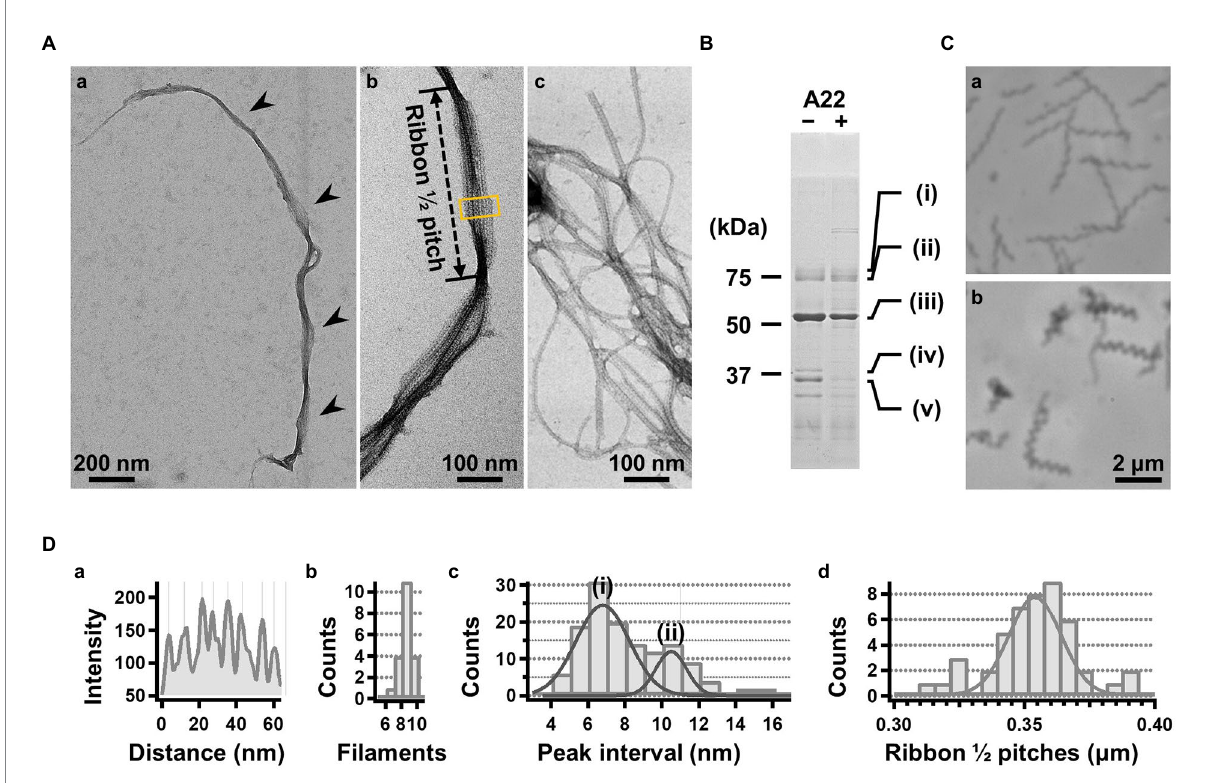
FIGURE 2 Isolation and characterization of the ribbon. (A) Isolated ribbon structure. (a) The whole structure of the isolated ribbon with helicity as shown by periodical wide positions (marked by arrows). (b) The magnified image of the isolated ribbon and the helical pitch is indicated by a bidirectional arrow. (c) Ribbon fraction isolated from cells treated with A22. (B) Protein profiles of the ribbon fraction isolated from cells untreated and treated with A22. (C) Cell images before (a) and after (b) treatment with 1 mM A22 for 2 min. (D) Numerical characterization. (a) Sectional image profile of the area boxed in panel (A b). The peaks correspond to the center of the protofilament. (b) Histogram for the number of protofilaments involved in a ribbon. (c) Histogram for the protofilament width in ribbons. The distribution can be fitted by two Gaussian curves marked (i) and (ii), with peaks around 7.0 and 10.5 nm, respectively. (d) Histogram for the helical pitches of the isolated ribbon, fitted by a Gaussian curve with a peak at 351 ± 16 nm ( n = 47).